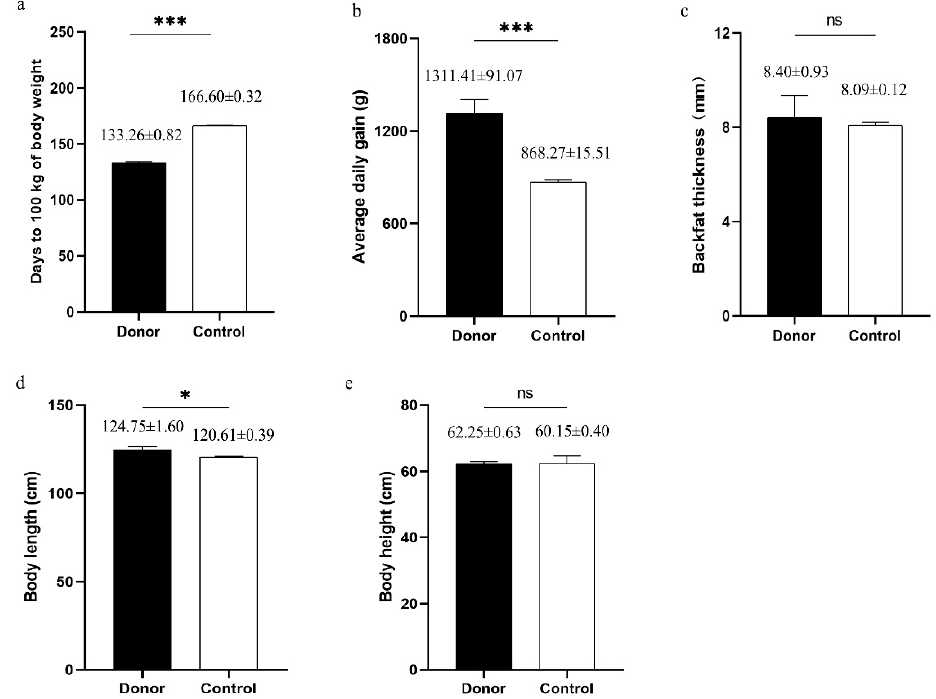
Figure 1. Growth performance of donor boars ( n = 4) and control boars ( n = 36). ( a ) Adjusted days to 100 kg of body weight. ( b ) Average daily gain between adjusted 30 kg to 100 kg of body weight; ( c ) Backfat thickness adjusted to 100 kg of body weight; ( d ) Body length. ( e ) Body height. * stands for p ≤ 0.05, *** stands for p ≤ 0.001. ns stands for nonsignificant differences.